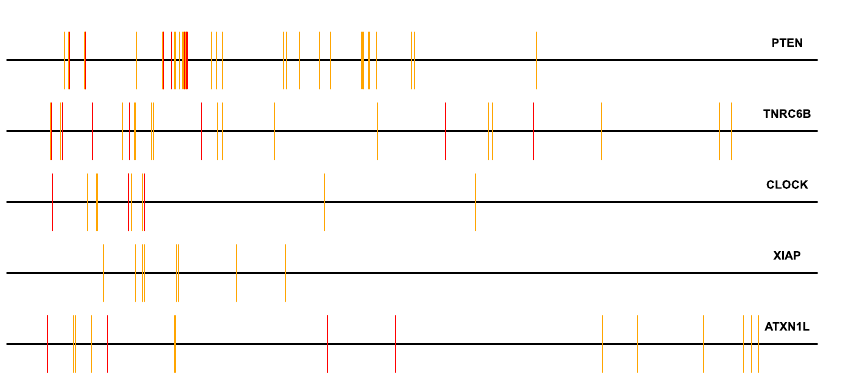
Figure 4. Distribution of MREs. Figure shows the location of MREs from PTEN targeting miRNAs on selected top candidates. The 3 ′ UTR sequence has been mapped to the the interval [0, 1] and the location of MREs are scaled accordingly. Red lines indicated MREs from experimentally validated PTEN miRNAs and orange bars are form PTEN targeting miRNAs as determined by PAR-CLIP